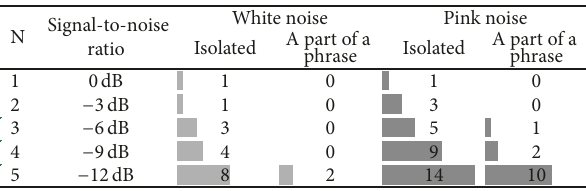
Figure 14: Number of tested words (from 15), the score of recognition of which did not exceed 50% at each level of signal-to-noise ratio.